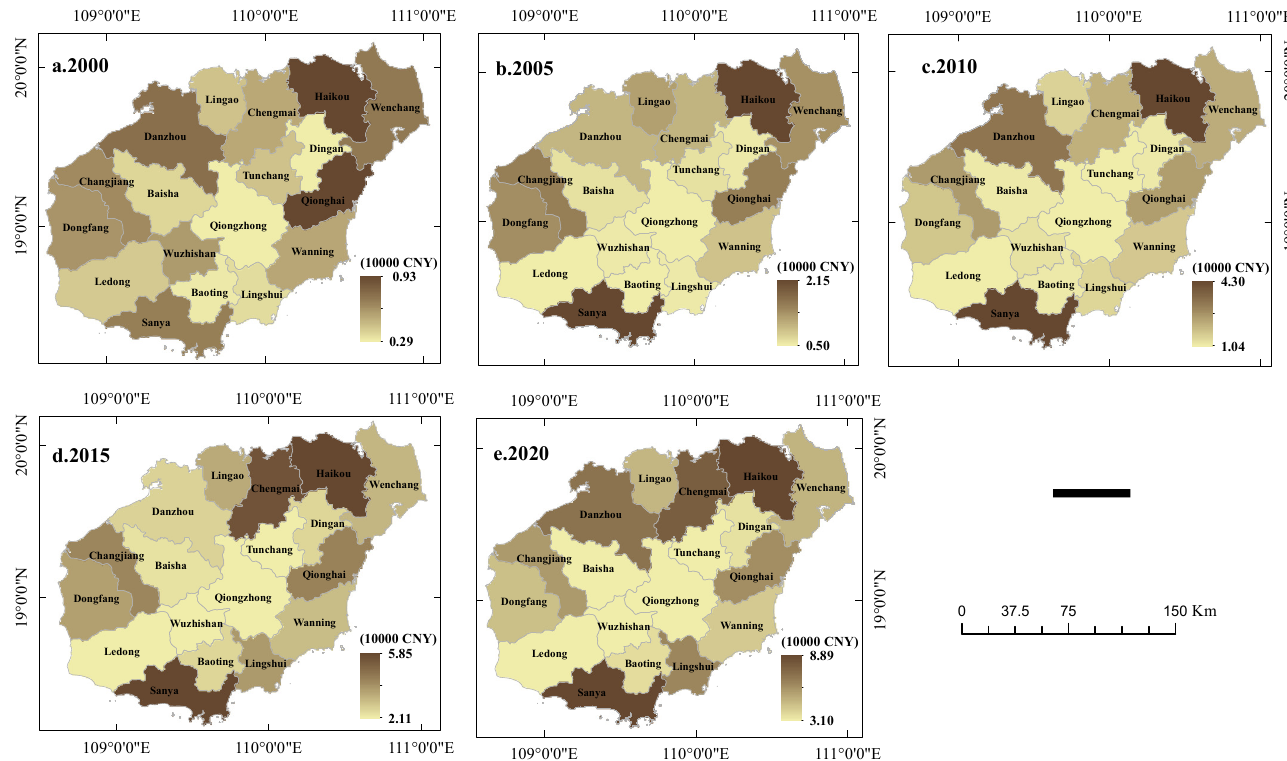
Figure 10. The per capita GDP of Hainan Province changed dramatically in different years and increased rapidly from 2000 to 2020. Spatial distribution was contrary to the spatial distribution of ESV, which showed a distribution pattern of being low in the middle and high in the surrounding areas. Areas with high GDP per capita were mainly distributed in the coastal plains, with Haikou and Sanya having the highest GDP, and the central mountainous areas had low GDP per capita. In 2020, the GDP per capita of Sanya city was 88,900 CNY and that of Ledong County was only 31,000 CNY, which showed that the uneven economic development of Hainan Province was relatively obvious.